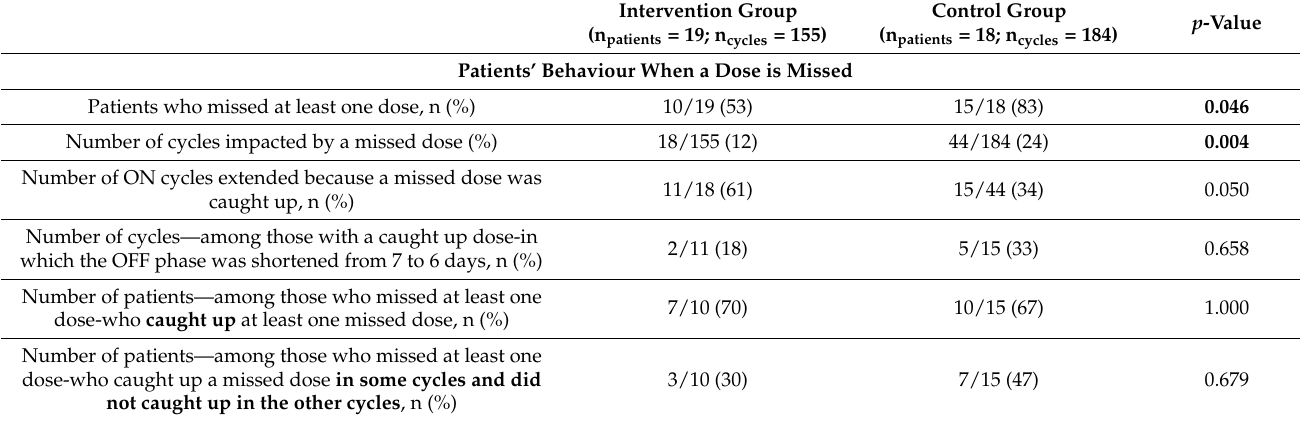
Table 2. Patients’ palbocilib management behaviour; clinical, administrative or patients’ personal events that occurred during the monitored